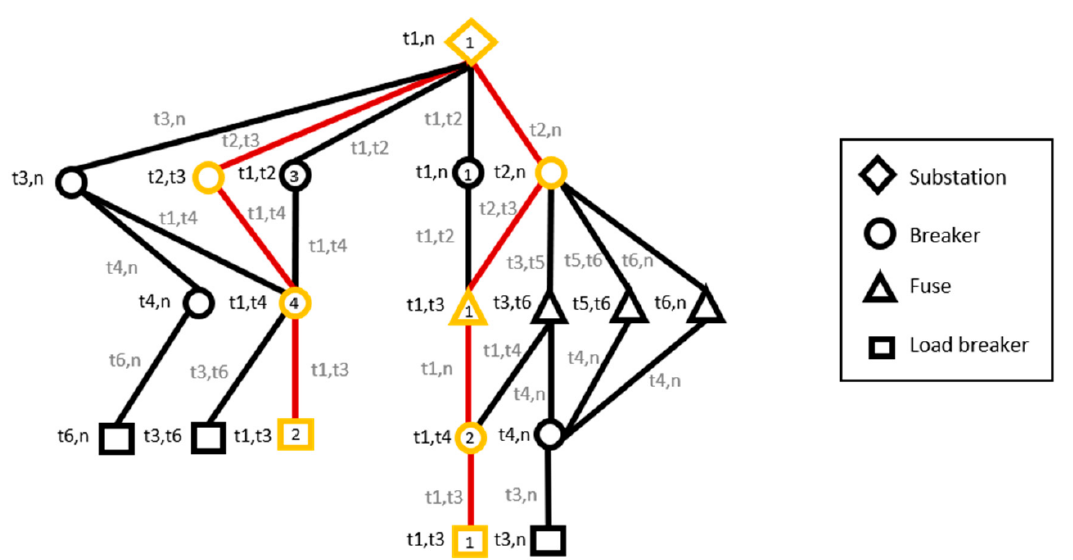
Figure 14. Obtaining the state of a network model (approach 2).